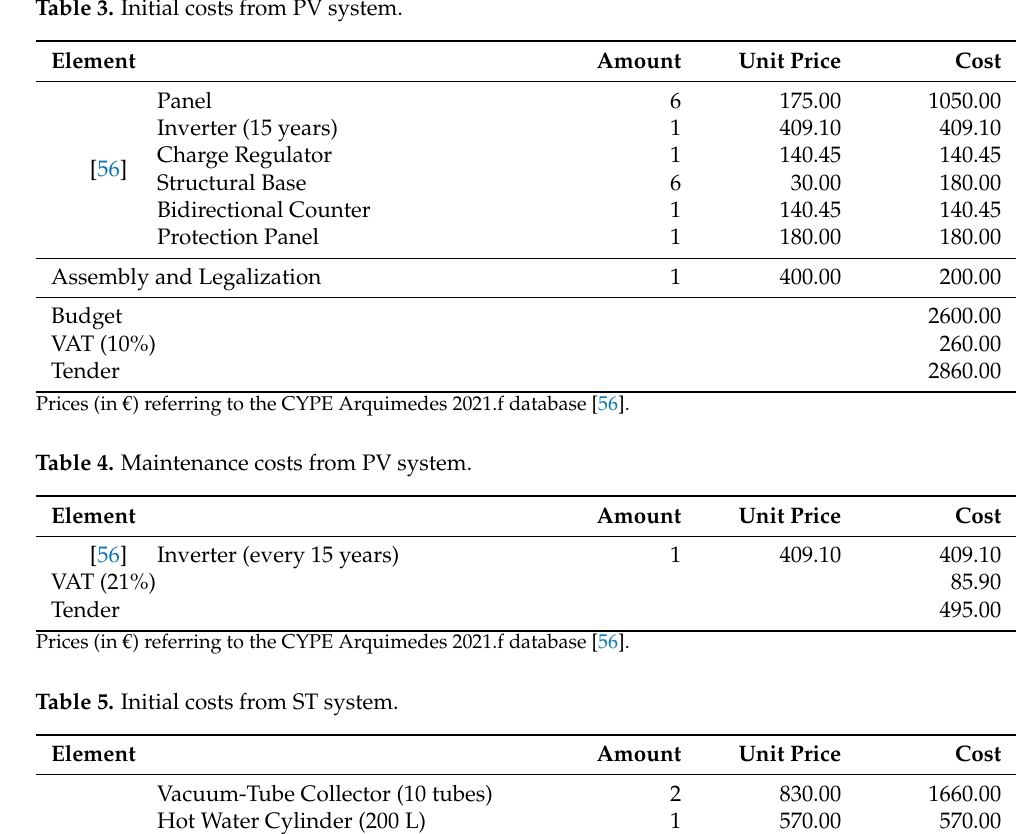
Table 3. Initial costs from PV system.